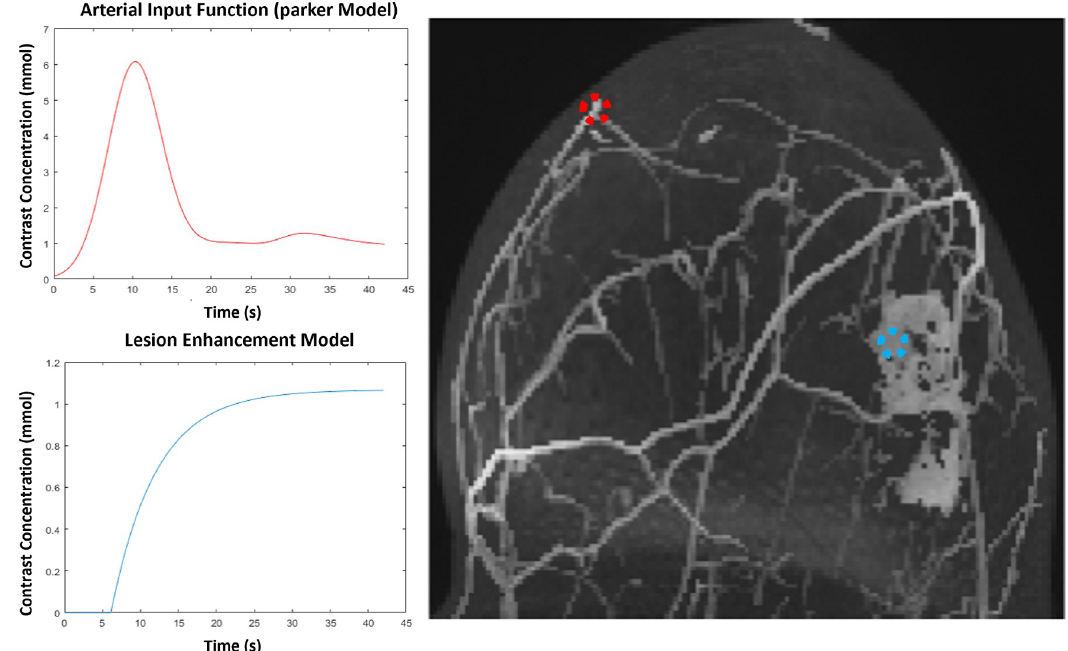
Fig 1. A maximum-intensity projection of a sample phantom. The red dashed circle (upper left) shows a sample voxel enhancing via the AIF; the blue dashed circle (middle right) shows a sample voxel enhancing via the EMM.